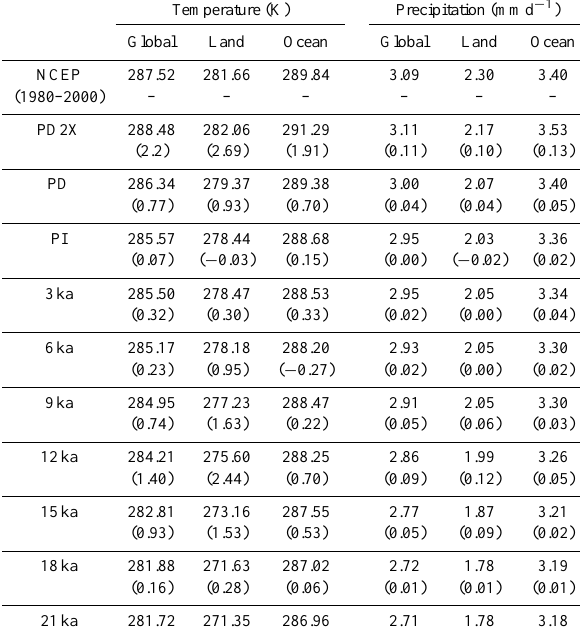
Table 2. Annual average 2m air temperatures and precipitation rates for the time slice simulations. NCEP is from the National Cen- ter for Environmental Predication NCEP/NCAR Reanalysis data set (Kalnay et al., 1996), PD2X is the 2 × CO 2 simulation, PD is present day, and PI is preindustrial. Parenthetical values are the changes from the previous time slice, e.g., the global average temperature for the PD is 0.77 ◦ C warmer than the